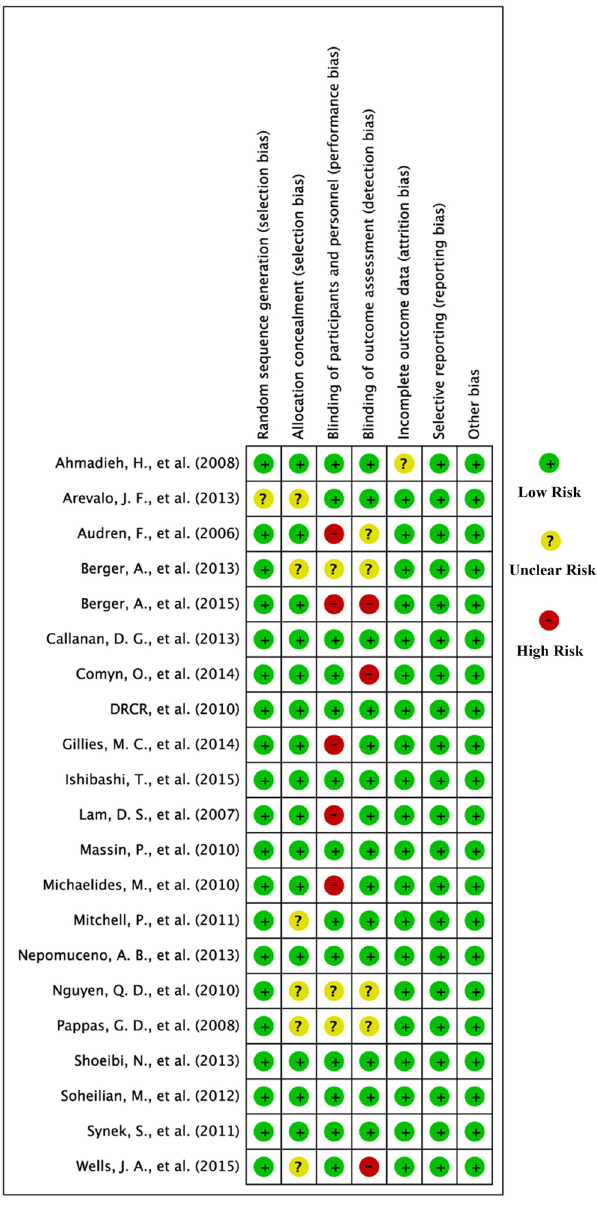
Fig 4. Risk of bias